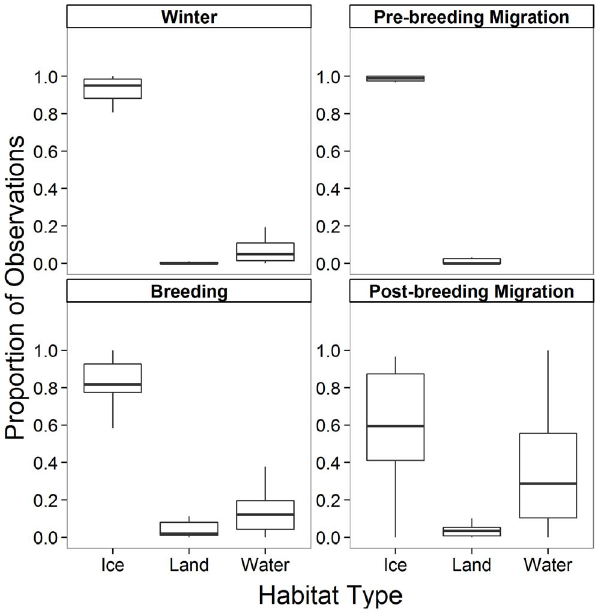
Fig. 3. Median and 25 th and 75 th quartiles of the proportion of observations of the 12 satellite-tagged ivory gulls over ice, land or water in winter (n 5 15 bird-seasons, 403 days), b) pre-breeding migration (n 5 12, 62), c) breeding (n 5 21, 337) and d) post-breeding migration (n 5 19, 140). Whiskers represent values within 1.5 times the interquartile range. Total number of days with observations was 942 over the study period, July 2010- July